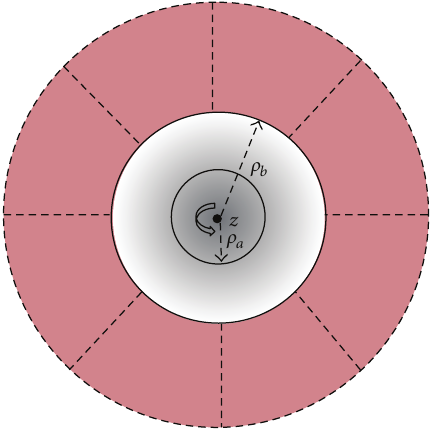
Figure 1: Cross-sectional view of a three-layer LCOF with the outermost section filled with liquid crystal (the dashed lines in the radial direction indicate the orientation of the liquid crystal